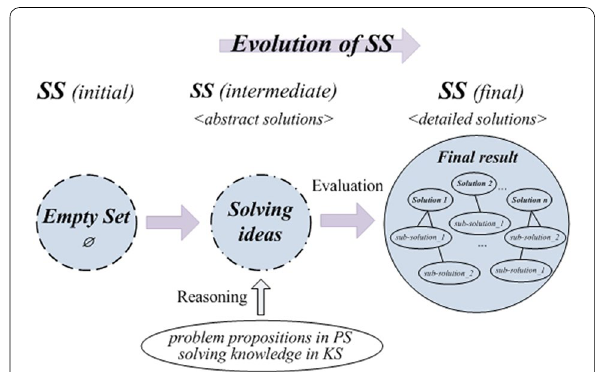
Figure 8 Evolution of the solution